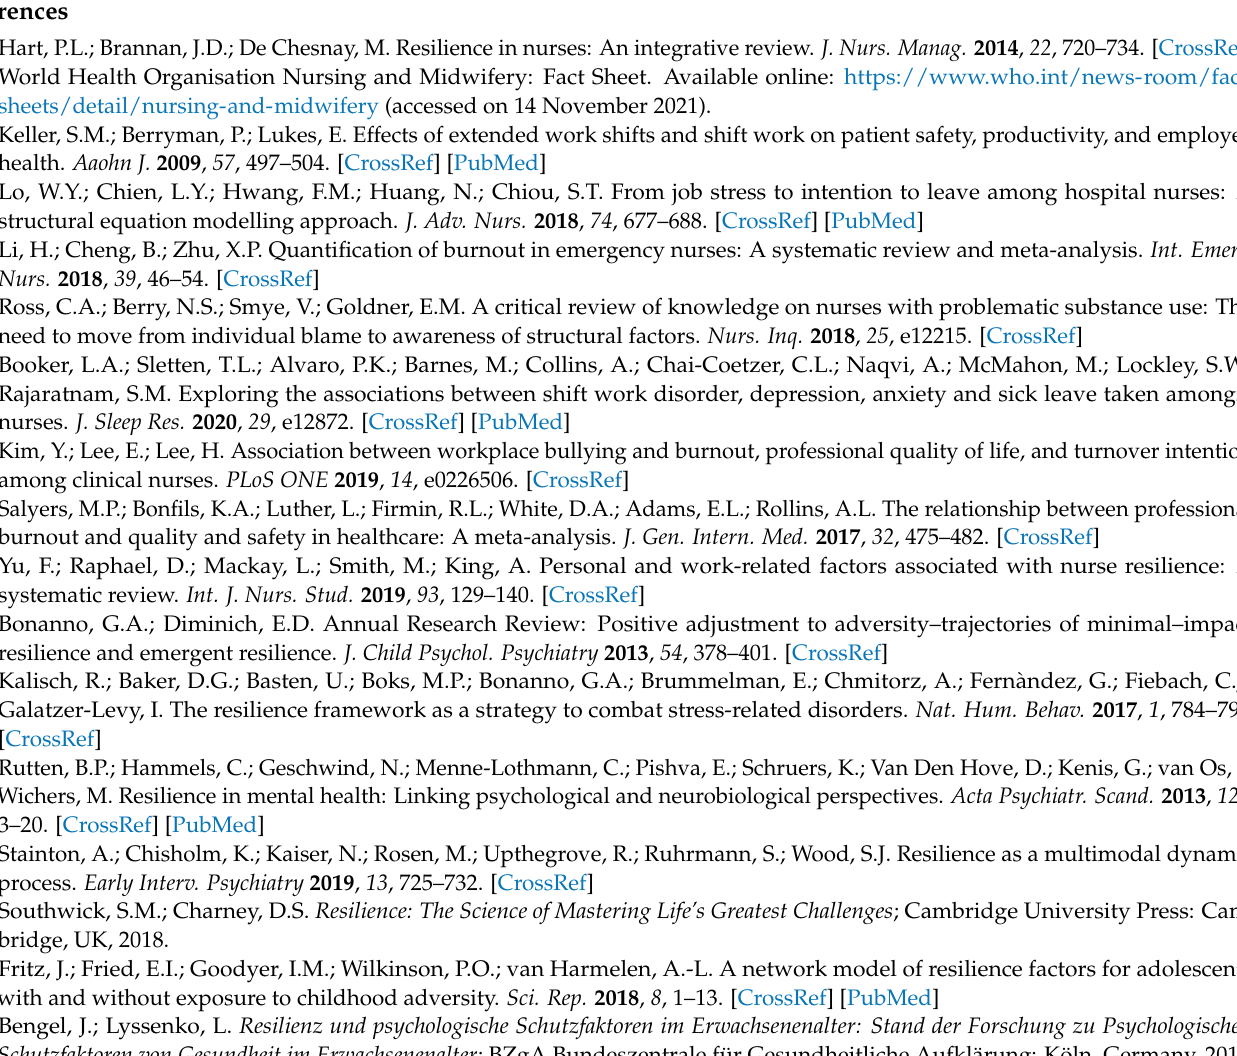
Figure A3. Distribution of the stressor load for the five measurements.